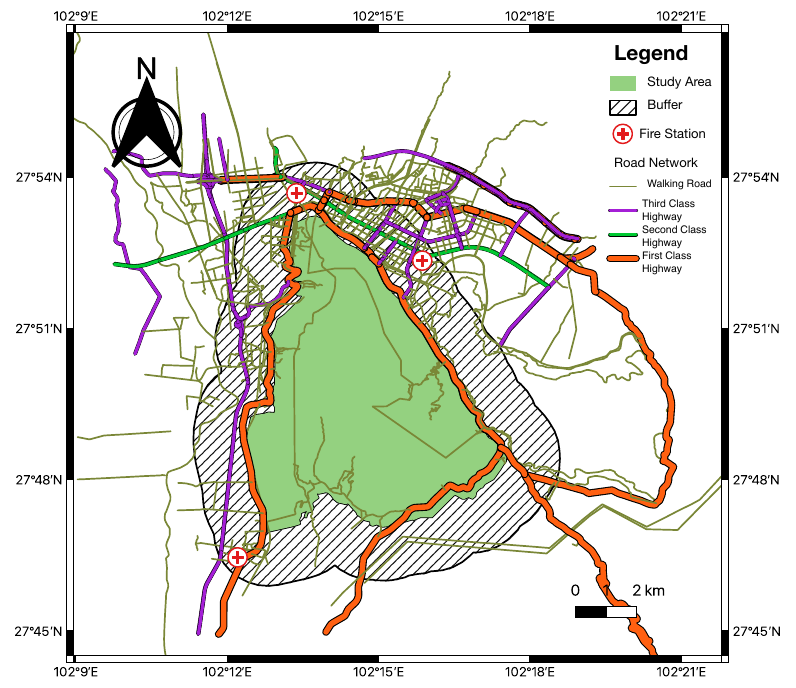
Figure 5. Distribution of Road Network in Study Area, and three fire stations in the area that can respond promptly to fires that occur in the area. Additionally, different types of roads are also delineated in the map (The road network information is sourced from Open Street